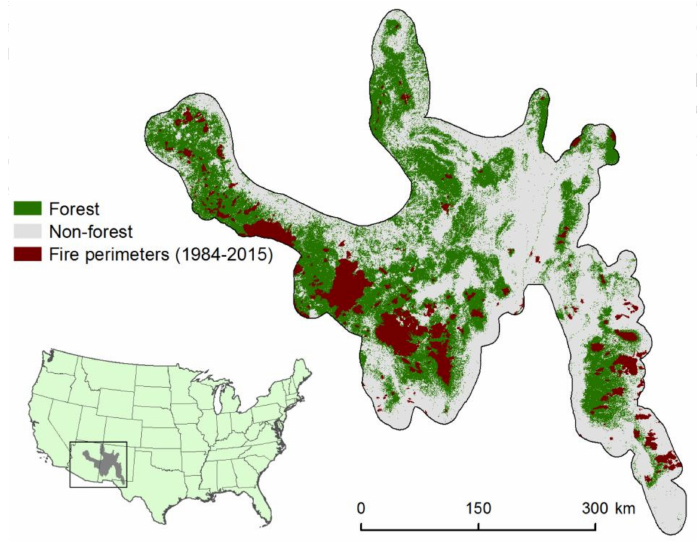
Figure 1. Study area map shows the distribution of forest, non-forest, and fire in our study area (the Arizona-New Mexico Mountains ecoregion). Inset shows this ecoregion’s location in the context of the contiguous